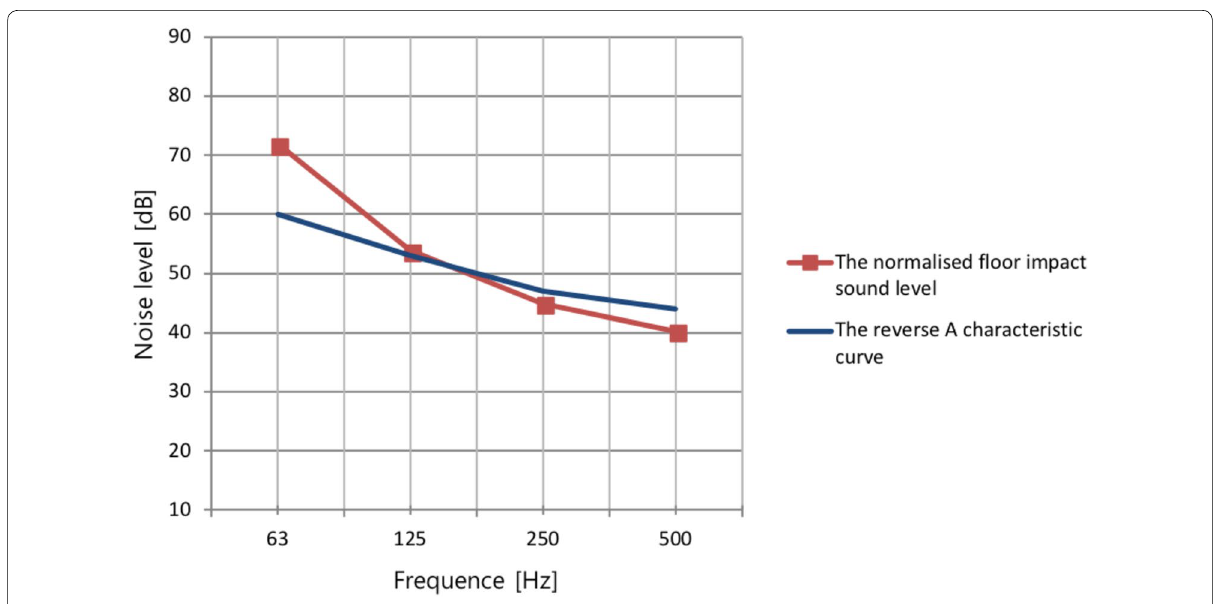
Fig. 6 Test result of the heavyweight floor impact noise.